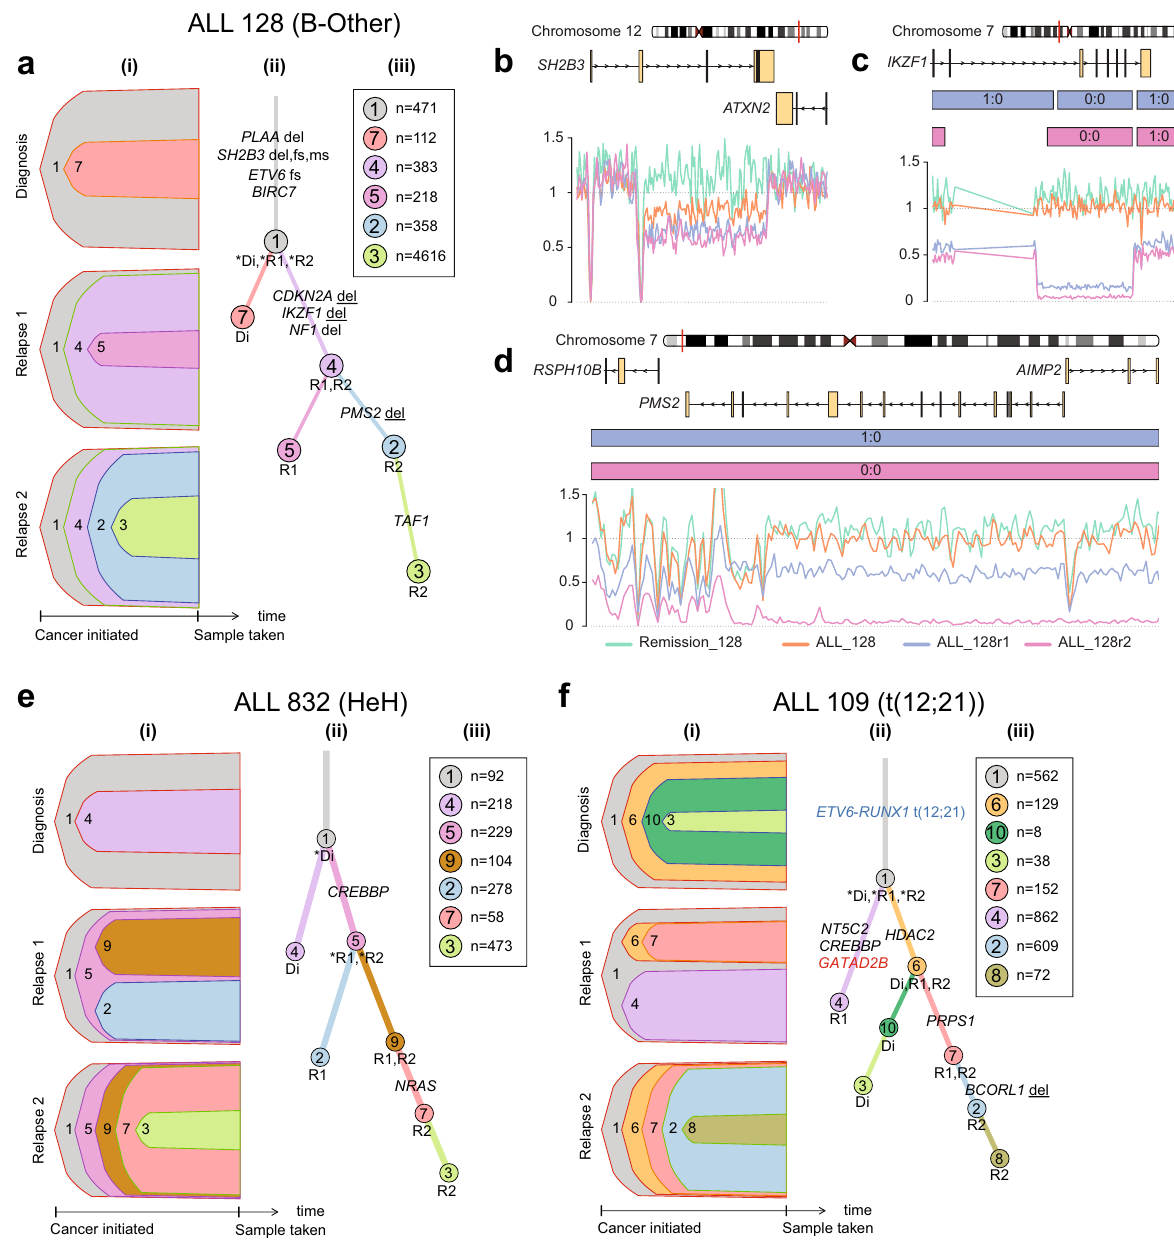
Figure 5. Clonal evolution in ALL patients displaying the “persistent clone” or “founding clone” trajectories. Panels a, e and f illustrate the two clonal evolutionary trajectories in three representative ALL patients. In each of the panels a, e, f section (i) shows the clones and subclones identified at diagnosis, first and second relapse, where clone 1 in (grey) represents the founding clone. The height of the colored fields corresponds to the proportion of the clones in a sample. Section (ii) shows the clones and subclones identified at diagnosis (Di), first (R1) and second relapse (R2). Each color-coded branch shows the known and putative driver genes identified at each time point, with the gene names highlighted in blue for fusion genes and in red for putative regulatory non-coding variants. Section (iii) shows the total number of somatic SNVs present in each clone using the same color code as in sections (i) and (ii). The most important putative driver mutations, somatic alterations: including small insertion-deletions, putatively regulatory non-coding mutations, copy number alterations and structural variants detected in our study are shown on the relevant branches of the evolutionary trees. ( del homozygous deletion; del heterozygous deletion; fs frameshift; sg stop gain; ms missense). (a) Consensus model for clonal evolution in patient ALL_128 in the B-other group illustrating the “persistent clone trajectory”. (b) Sequencing coverage plot for the SH2B3 gene on chromosome 12 in patient ALL_128 at diagnosis, first and second relapse and at remission (germline). (c) Sequencing coverage plot for the IKZF1 gene on chromosome 7 in patient ALL_128 at diagnosis, first and second relapse. (d) Sequencing coverage plot for the PMS2 gene in patient ALL_128 at diagnosis, first and second relapse. (e) Consensus model for clonal evolution in patient ALL_832 with high hyperdiploid (HeH) BCP-ALL illustrating the “persistent clone trajectory”. (f) BCP-ALL patient ALL_109 with the t(12;21) ETV6-RUNX1 translocation illustrates the “founding clone trajectory”. Additional details on the evolutionary trajectories are provided in the Supplementary